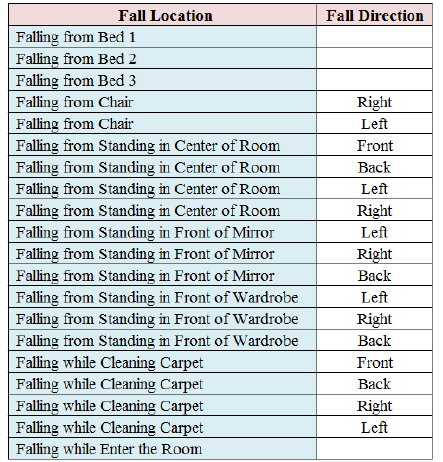
Figure 9: Room layout and three representative ac- tion paths